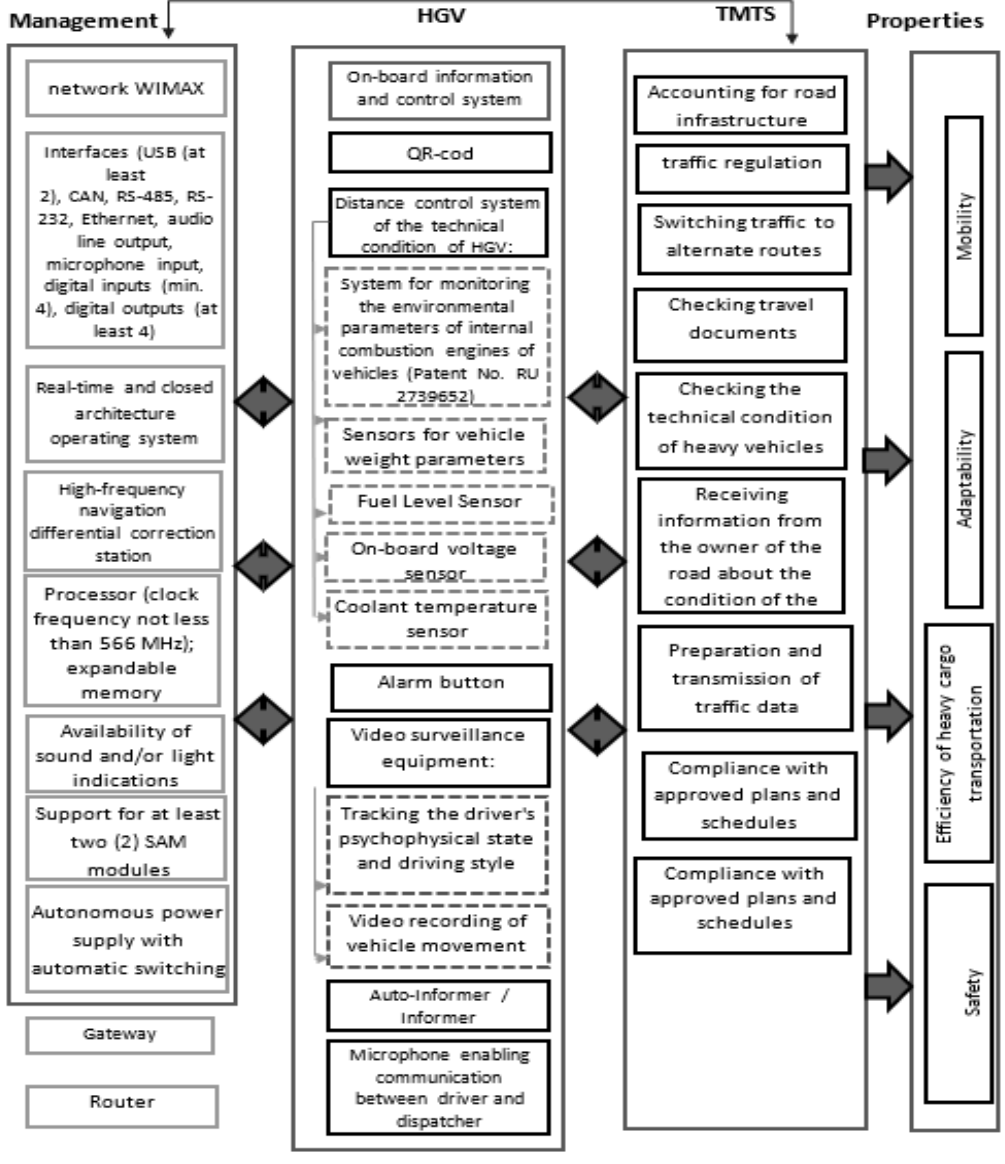
Figure 7. The architecture of the TASWC HGV. Table 2. Estimated operational indicators of the road with the implementation of TASWC